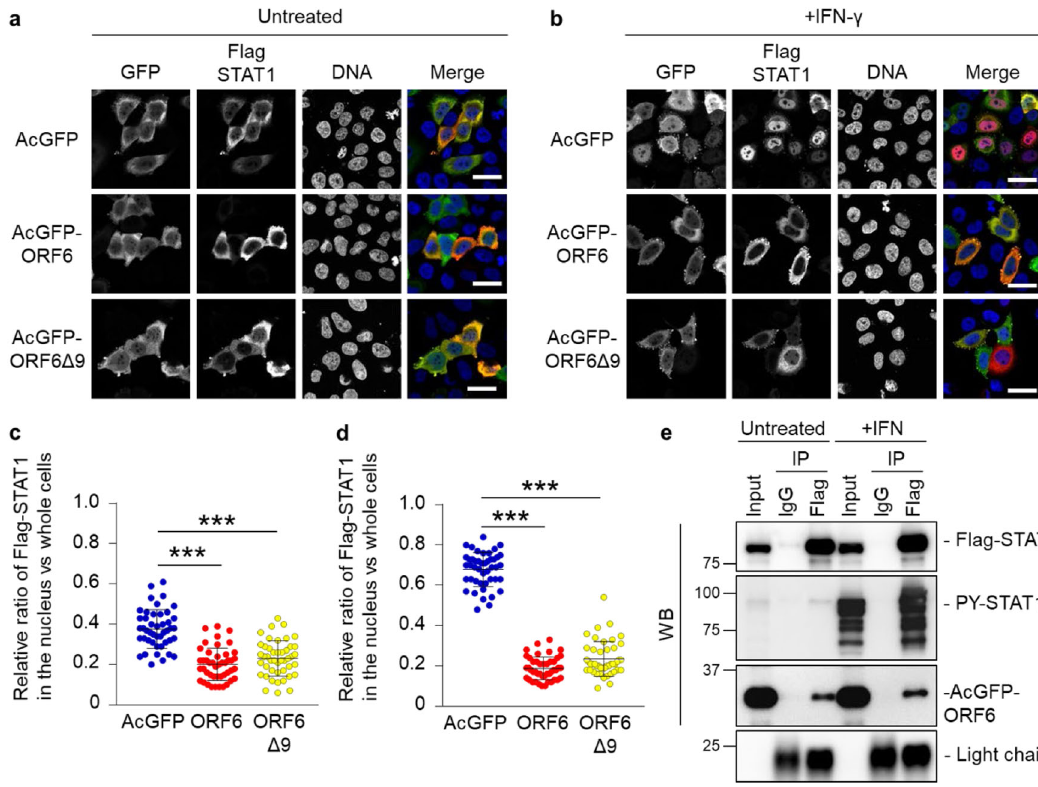
Fig. 3 ORF6 changes the subcellular localization of STAT1 in an IFN-independent manner. a , b Immuno fl uorescence of Flag-STAT1 in HeLa cells transfected with AcGFP, AcGFP-ORF6 WT, or AcGFP-ORF6 Δ 9 under an untreated condition a or following IFN- γ stimulation b . Anti-GFP and anti-Flag antibodies were used for the detection of AcGFP (green) and Flag-STAT1 (red), respectively. DAPI was used to stain the DNA (blue). Scale bars: 30 μ m. c , d The graphs represent the relative fl uorescence values of Flag-STAT1 in the nucleus compared to those of the whole cells under an untreated condition in a or following IFN- γ stimulation in b , respectively. Signal intensities from total 45 nuclei from two independent experiments. *** P < 0.001, one-way ANOVA. error bars represent SD. e Immunoprecipitation (IP) of Flag-STAT1 from HEK293 cells transfected with AcGFP-ORF6 which is tagged the HA sequence following stimulation with IFN- γ ( + IFN). Normal mouse IgG was used as a negative control for IP. Input was 1/130 dilution of cell lysates used for the reaction. Flag-STAT1 and AcGFP-ORF6 were detected by either anti-Flag or anti-HA antibodies, respectively (WB). The stimulation of IFN- γ was identi fi ed by the detection of PY-STAT1 using anti-PY-STAT1 antibody. Light chain indicates the precipitated